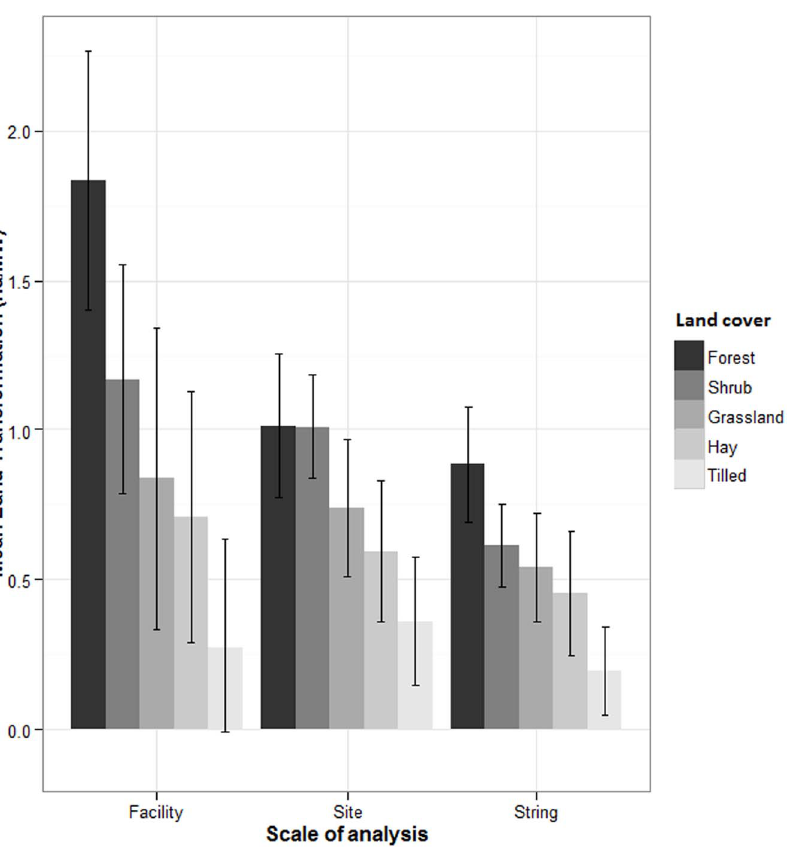
Figure 1. Mean ( ± 95% Confidence Interval) of the land transformation associated with wind facilities in different land use and cover (‘‘Land cover’’) categories at 3 spatial scales of analysis.